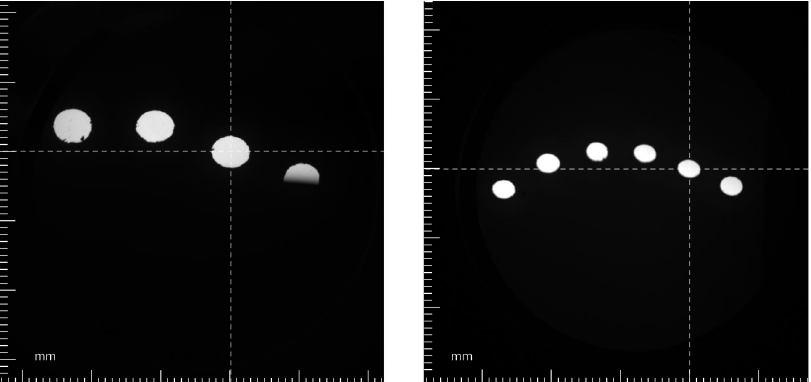
Figure 9. Observed camera image of the three beam spots beyond the aperture in the Setup 1 configuration, left, and with six beam spots beyond the aperture in the Setup 2 configuration, right. Both images were taken with the lens off. The dashed lines indicate the beam axis and the central beam spot.